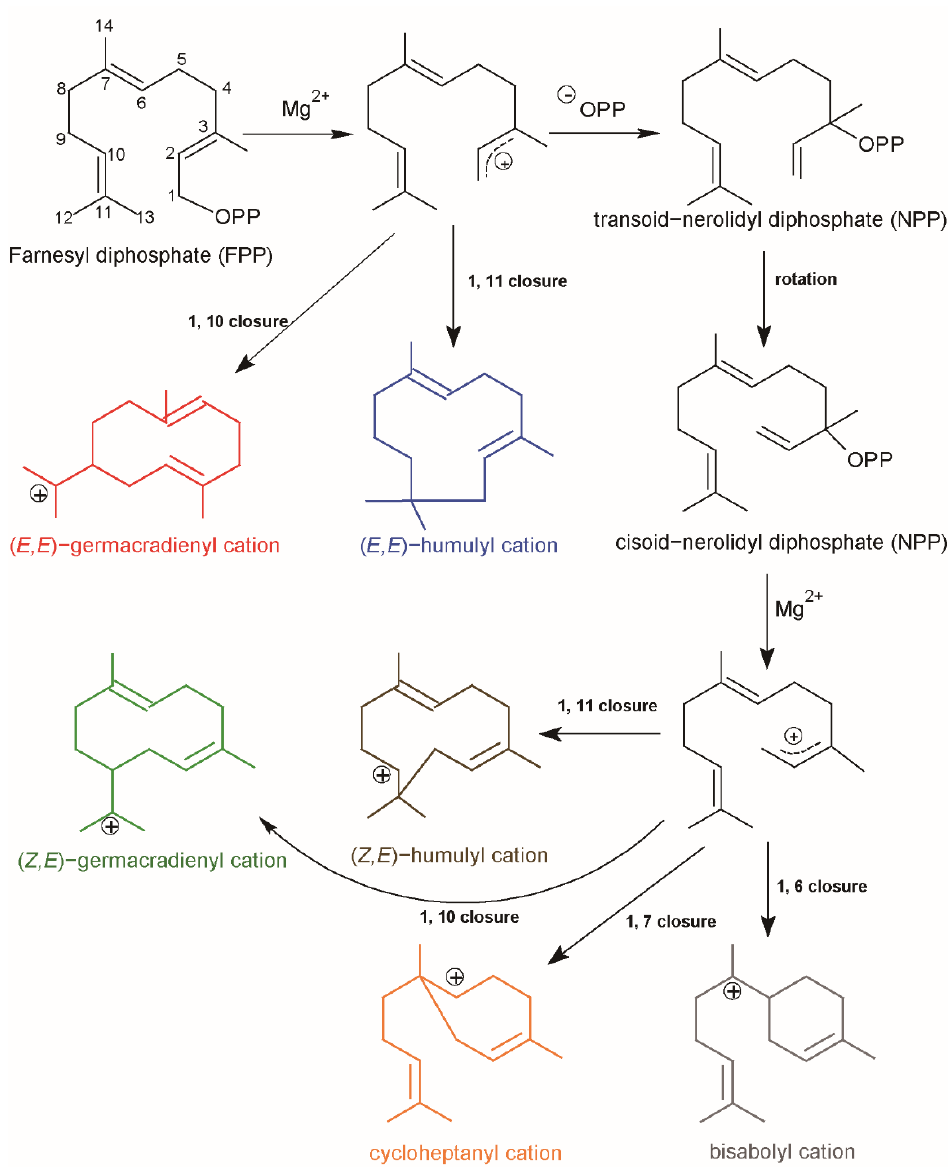
Figure 1. The reaction mechanism of sesquiterpene production starting with FPP. Farnesyl cation is formatted by losing the diphosphate moiety (OPP). Then, the farnesyl cation can be converted to the nerolidyl cation. Possible cyclizations for both cations are indicated in the